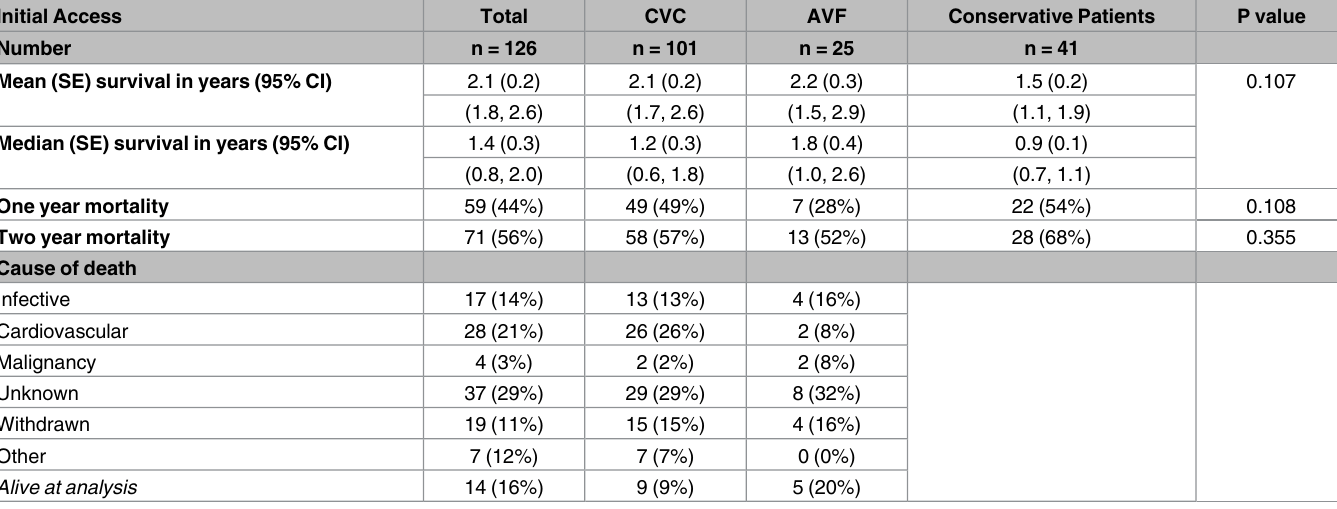
Table 2. Dialysis and Survival